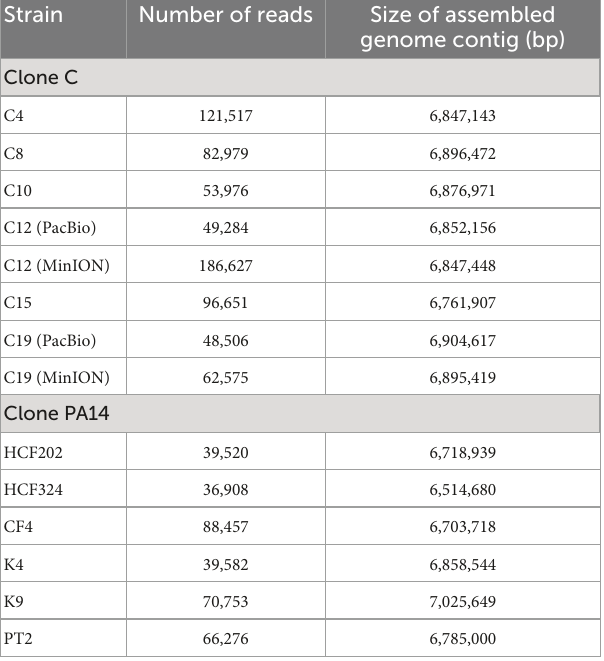
TABLE 2 Read numbers of the analyzed long read datasets and assembled genome contig